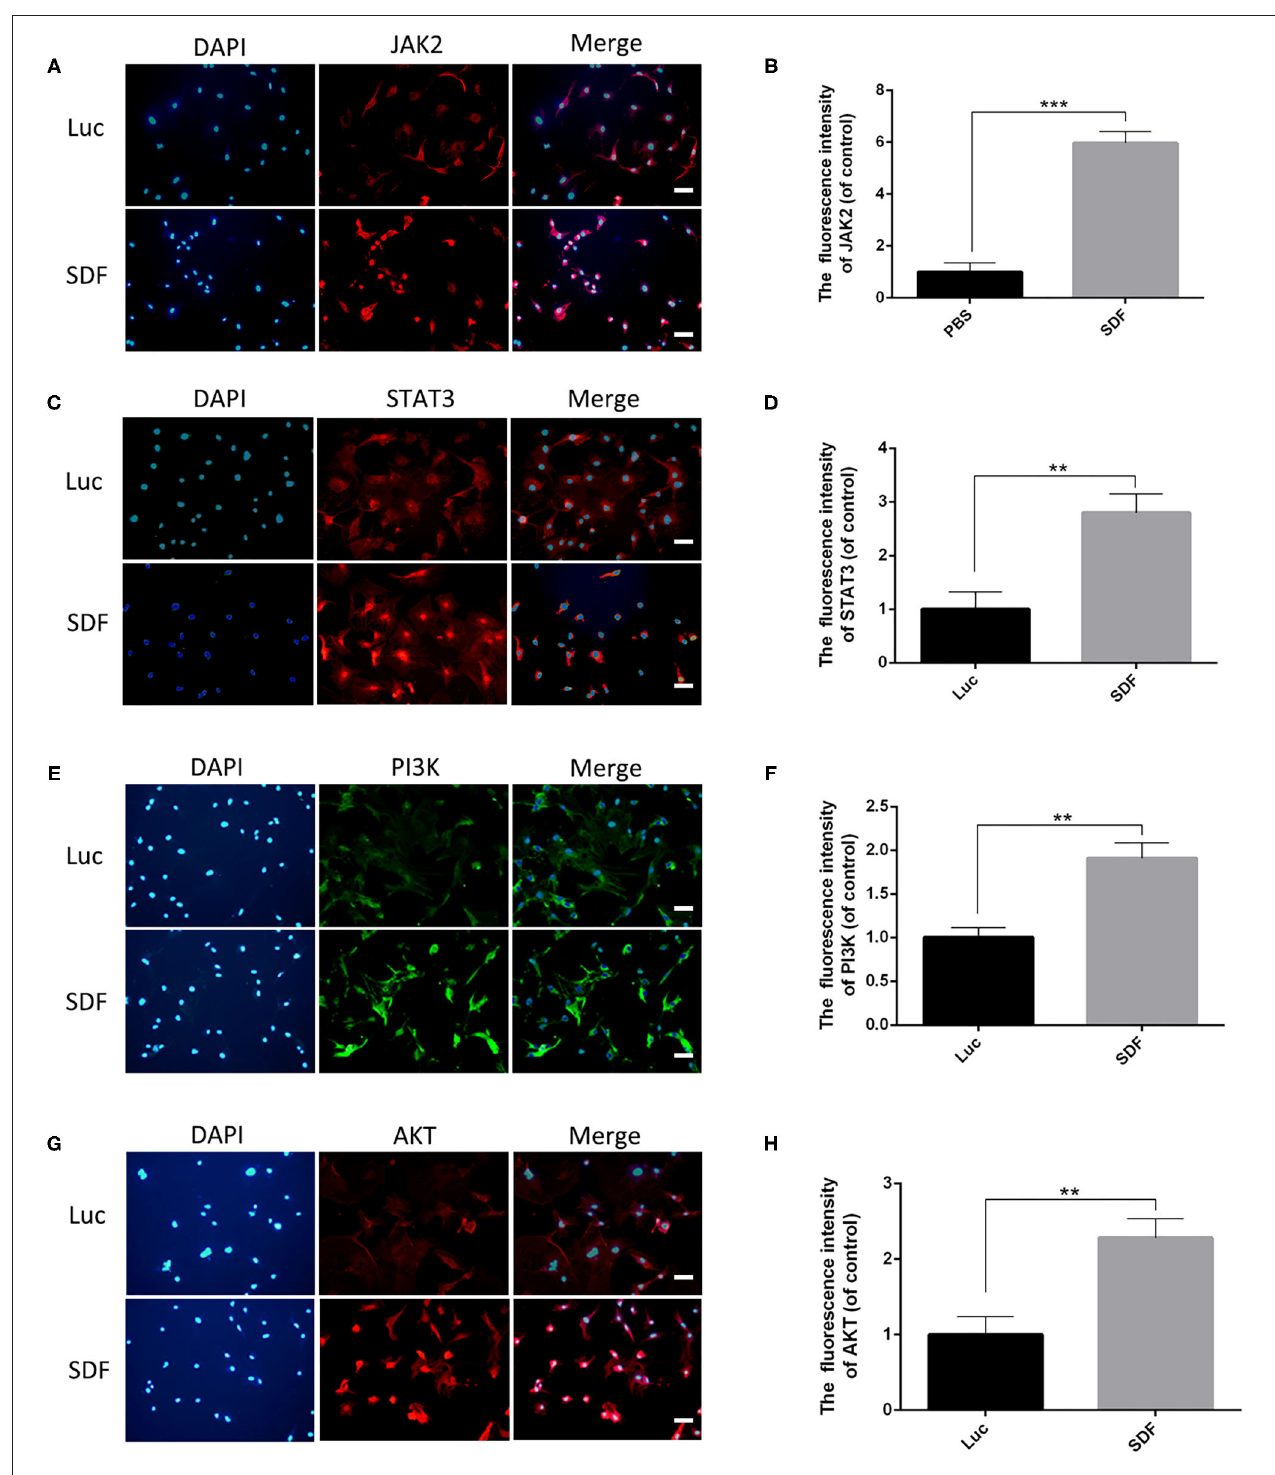
FIGURE 8 | Immunofluorescence analysis of fibroblasts transfected with SDF-1 α modRNA. Immunofluorescence staining with (A) anti-JAK2 antibodies (red) and DAPI (blue). (B) Quantification of immunohistofluorescence data (scale bar: 200 µ m). (C) Immunofluorescence staining with anti-STAT3 antibodies (red) and DAPI (blue). (D) quantified in each group (bar: 200 µ m). (E) Immunofluorescence staining with anti-PI3K antibodies (green) and DAPI (blue). (F) Quantification of immunohistofluorescence data (scale bar: 200 µ m). (G) Immunofluorescence staining with anti-AKT antibodies (red) and DAPI (blue). (H) Quantification of immunohistofluorescence data (scale bar: 200 µ m). Data represent the mean ± SD ( n = 5). ** P = (0.01–0.05), *** P < 0.01.